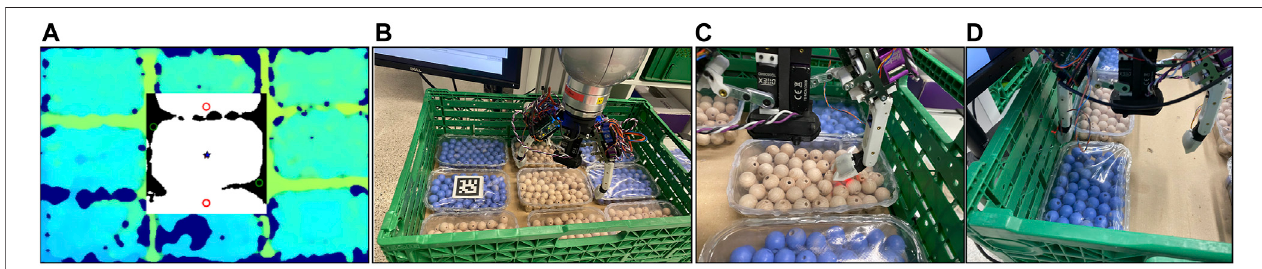
FIGURE 14 | Scenario P 3. From left to right: (A) fi nger position planner output, (B) CLASH 2F pose to grasp the fi rst punnet, (C) fi nger failed to push the punnet away from the wall, (D) second push strategy with the help of the free space around the